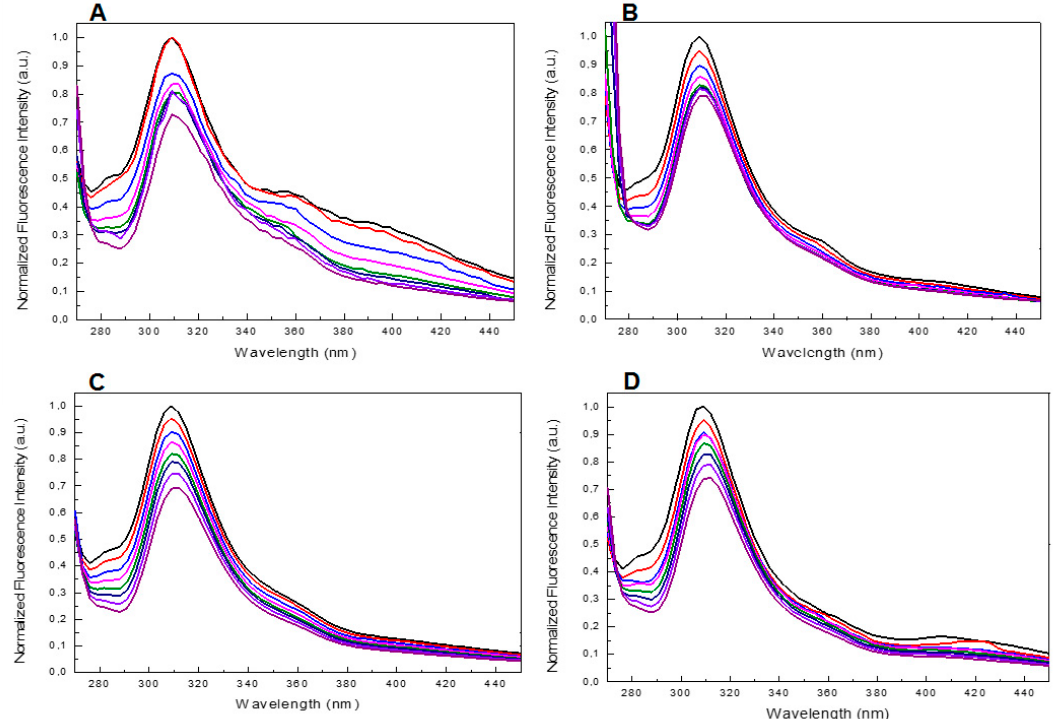
Figure 6. ( A ) and ( B ) Fluorescence spectra at different temperatures (from 25 to 95 °C, Δ T = 10 °C) of T30695 and 5’-DMAzo-T30695 excited at 255 nm acquired in the region 300–460 nm. ( C ) and ( D ). Fluorescence spectra at different temperatures (from 25 to 95 °C, Δ T = 10 °C) of TBA and 5’-DMAzo- TBA excited at 255 nm acquired in the region 300–460 nm. In all cases 5KWE was used as a solvent.